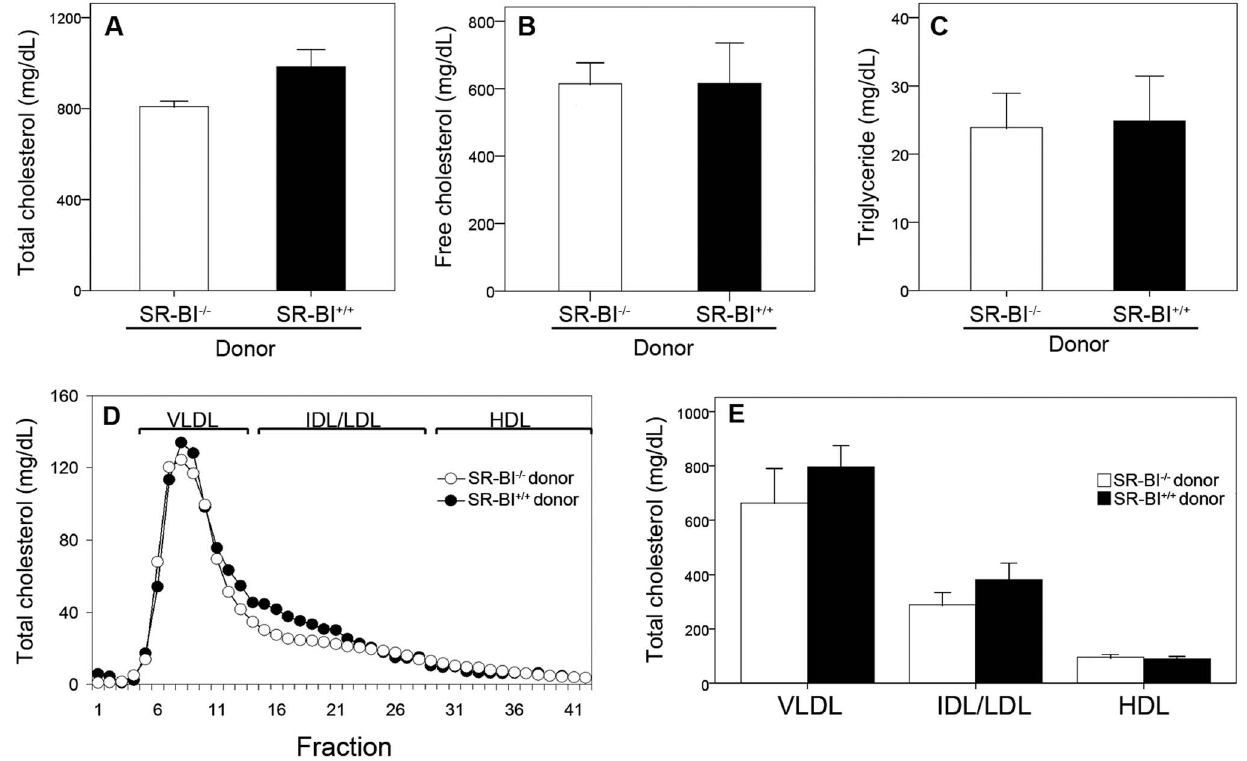
Figure 3. Restoration of SR-BI expression in BM derived cells did not alter lipids in HFCC diet fed SR-BI-null/apoE-hypomorphic mice. A. Total cholesterol, B. unesterified (free) cholesterol and C. triglycerides were measured in plasma collected from fasted SR-BI 2 / 2 R SR-BI 2 / 2 (white bars) and SR-BI + / + R SR-BI 2 / 2 mice (black bars) fed the HFCC diet for 3 weeks (n=6 mice/group). D. Averaged lipoprotein total cholesterol profiles from n=10 SR-BI 2 / 2 R SR-BI 2 / 2 (white symbols) and SR-BI + / + R SR-BI 2 / 2 mice (black symbols) fed the HFCC diet for 3 weeks. Fractions corresponding to the elution of purified human VLDL, IDL/LDL and HDL are shown at the top. E. Total cholesterol fractions containing VLDL-sized (1– 14), IDL/LDL-sized (15–28) and HDL-sized lipoproteins (29–42) from the lipoprotein total cholesterol profiles of individual mice were determined. Averages 6 standard errors are shown (n=10 mice/group). No statistically significant differences in values from SR-BI 2 / 2 R SR-BI 2 / 2 (white bars) and SR-BI + / + R SR-BI 2 / 2 mice (black bars) were detected.